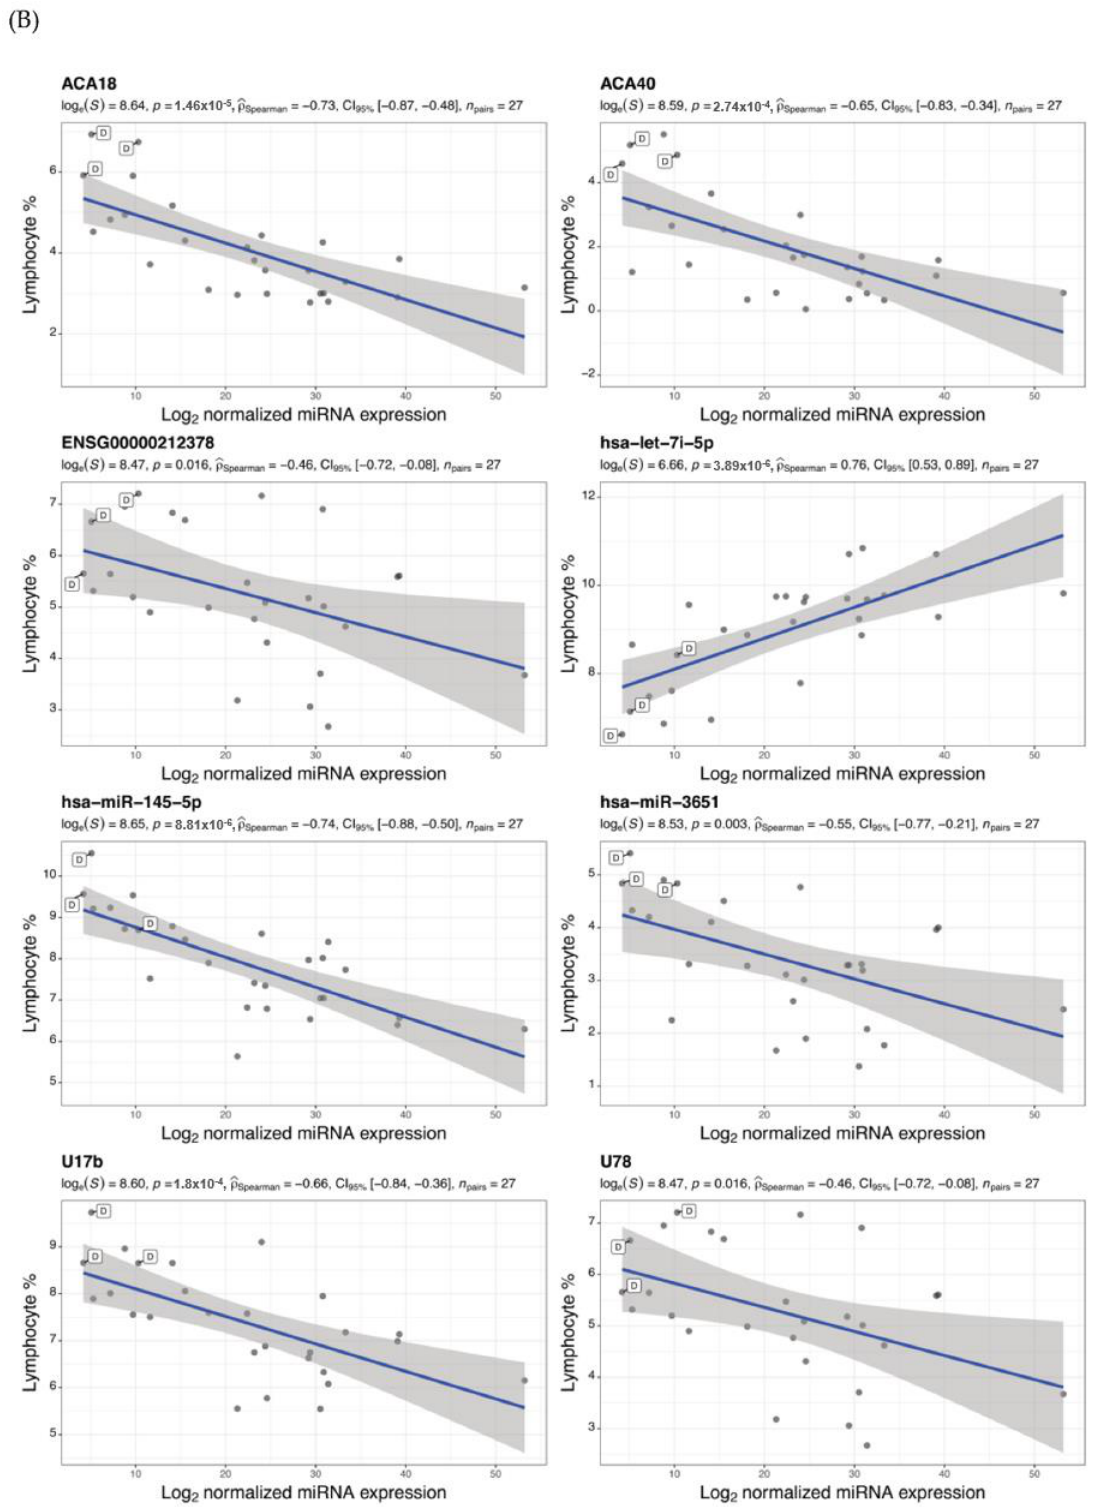
Figure 4. Correlation of ( A ) WBC count and ( B ) lymphocytes (%) with levels of common differentially expressed miRNAs and snoRNAs. Scatter plots x-axis represents Log 2 normalized miRNA expression level and y-axis as the clinical marker measurement. Each dot represents a single miRNA transcript, and those tagged with D letter show a deceased patient measurement. For all statistical tests in the plots, the APA standard for statistical reporting is shown for Spearman correlation test including evidence in favor of null over alternative hypothesis, natural logarithm of Bayes Factor, p -value, Spearman’s rank correlation coefficient, confidence intervals, and number of observations.